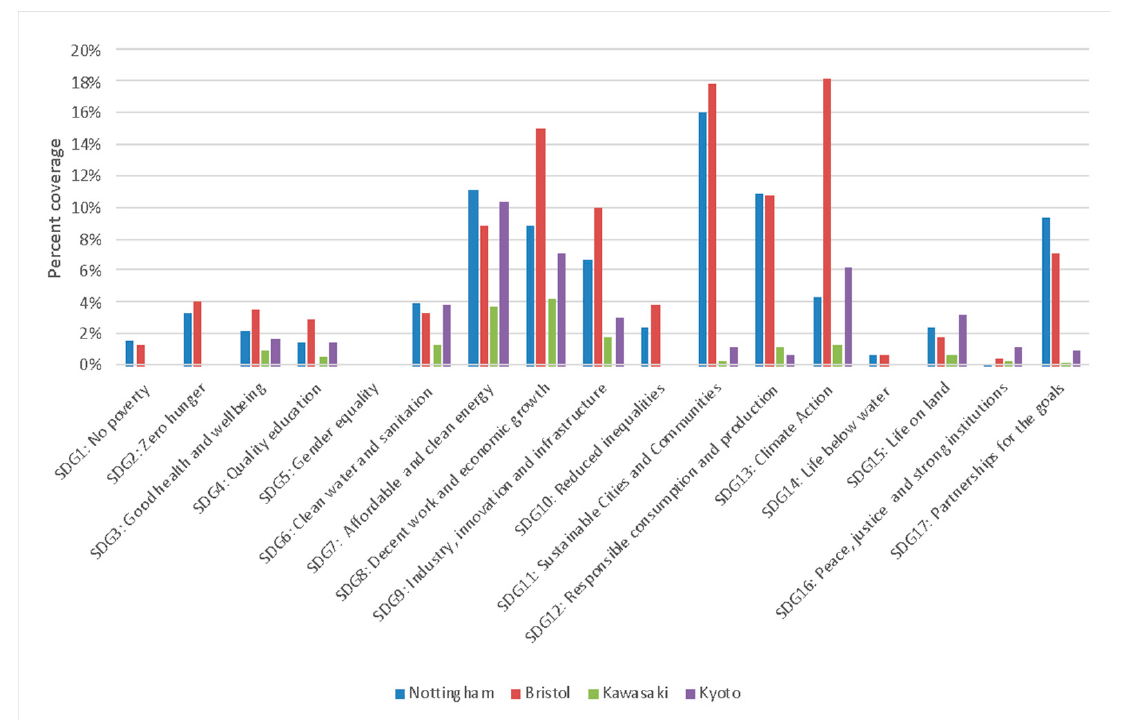
Figure 3. Percentage coverage of SDGs keywords in the climate plans of selected Japan and UK cities.